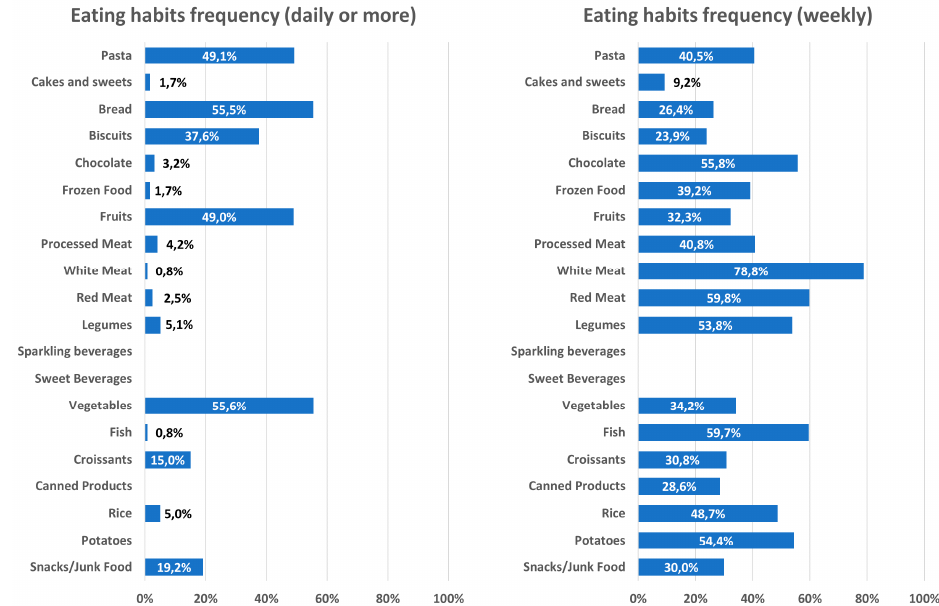
Figure 2. Histograms of reported frequencies of food consumption (daily or more on the left; weekly consumption on the right) for the whole cohort, based on food questionnaire answers.